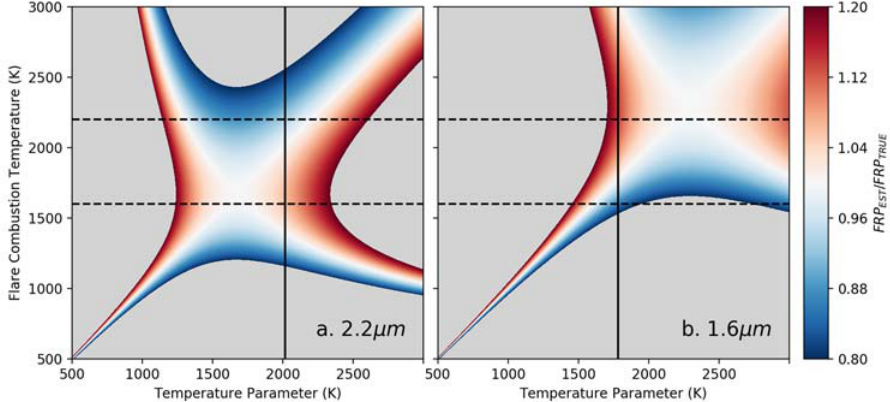
Figure 3. Accuracy of SWIR-radiance method derived gas flare FRPs, as calculated using modelled flare scenarios of varying temperatures and with an assumed flare of area 100 m 2 in a 1 km 2 pixel. Plots show the ratio between FRP estimated using the modelled flare-emitted spectral radiance calculated via the Planck function and the SWIR radiance approach and that calculated directly from Stefan’s law (i.e., ‘truth’). Results are show for both ( a ) 2.2 µm and ( b ) 1.6 µm wavelengths and with the FRP coefficient used in the SWIR radiance method calculated for a range of different emitter temperatures. The x -axis plots the temperature parameter used to compute a (see Equation (2)) in the FRP coefficient and the y -axis the modelled flare temperature. Black vertical lines represent the parameter temperature that gives the smallest maximum bias between the SWIR-radiance method-derived FRP and the true FRP, whilst dashed lines represent assumed flaring temperature range (1600 K to 2200 K) over which the biases are computed.